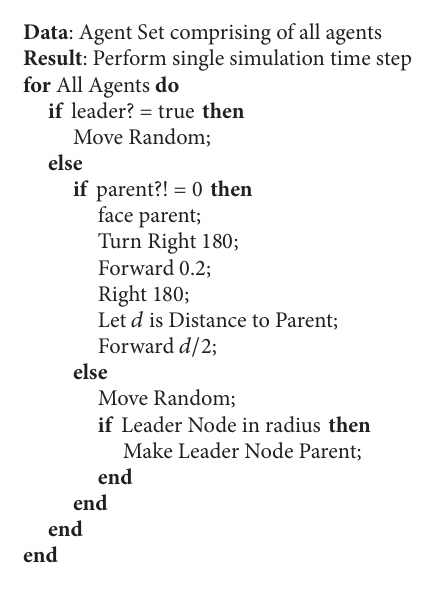
Algorithm 2: Main animation